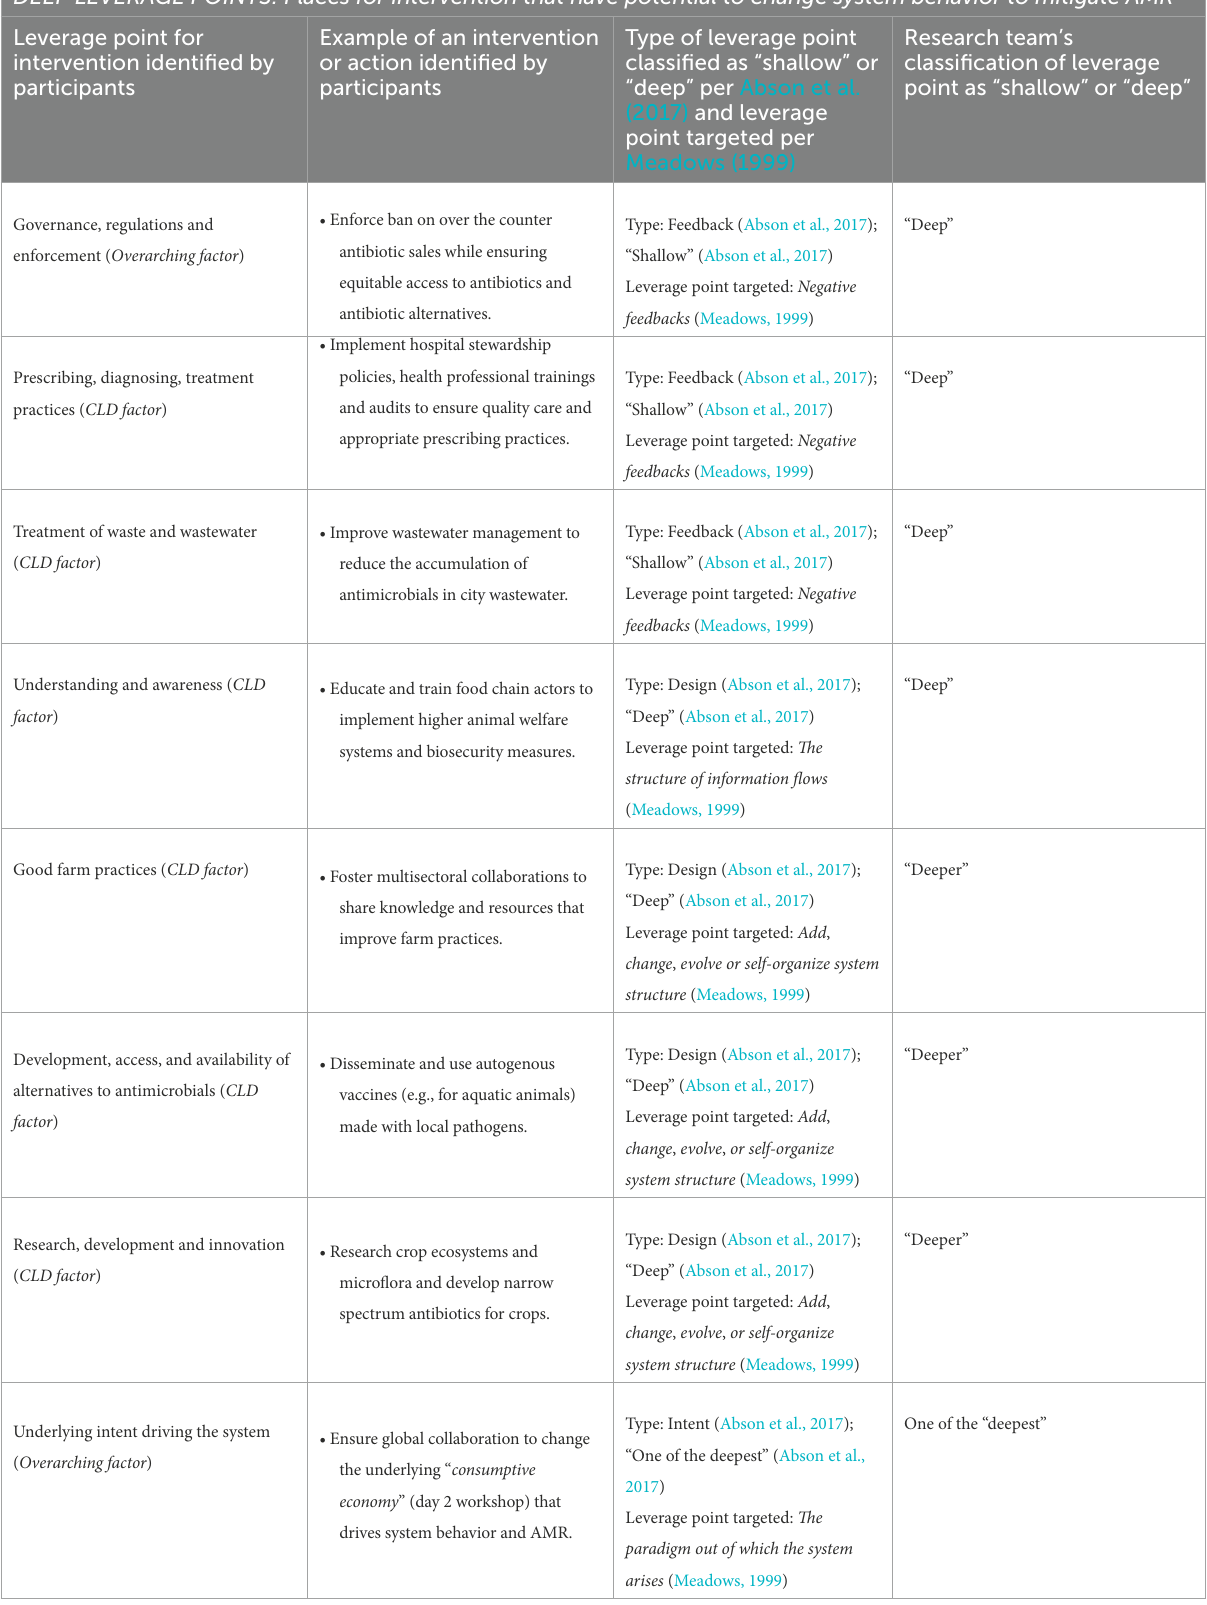
TABLE 4 Deep leverage points and suggested associated actions. DEEP LEVERAGE POINTS: Places for intervention that have potential to change system behavior to mitigate AMR Leverage point for intervention identified